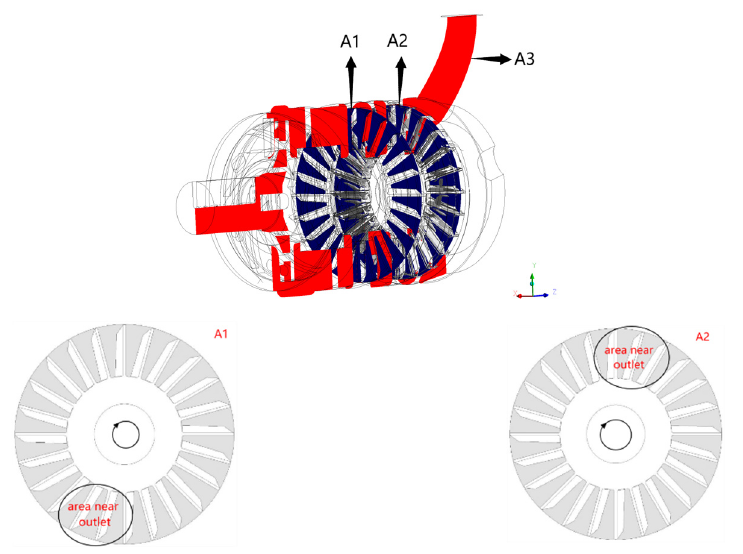
Figure 7. Overall description of a multistage side channel pump: ( a ) streamline and velocity; ( b ) surface pressure.